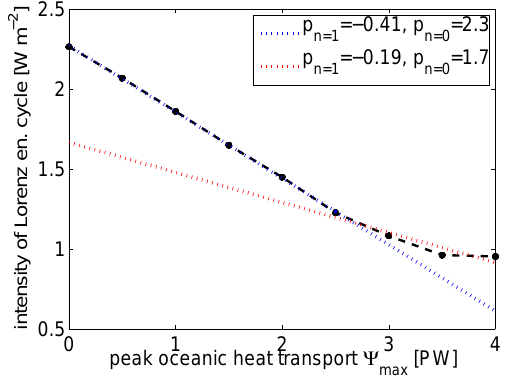
Figure 20. Time average of the intensity of the Lorenz en- ergy cycle ˙ W (lower) for steady state obtained for vary- ing oceanic heat transport. Dotted line represents best lin- ear fit for (i) 0.0PW ≤ OHT max ≤ 2.5PW (blue) and for (ii) 2.5PW ≤ OHT max ≤ 4.0PW (red) with polynomial coefficients of n th order, p n = 1 and p n = 0